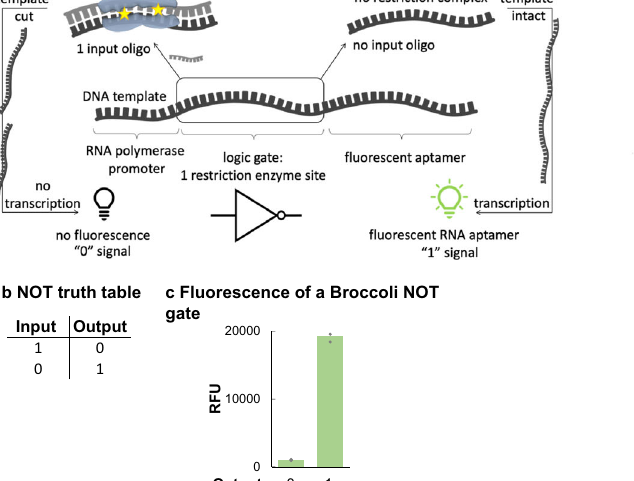
withinasamplesetisrepresentedbyagraymarker.Thegreenbarsaretheaverages of each sample set ( n =3). All experiments were repeated three times indepen- dently. Source data are provided as a Source Data fi